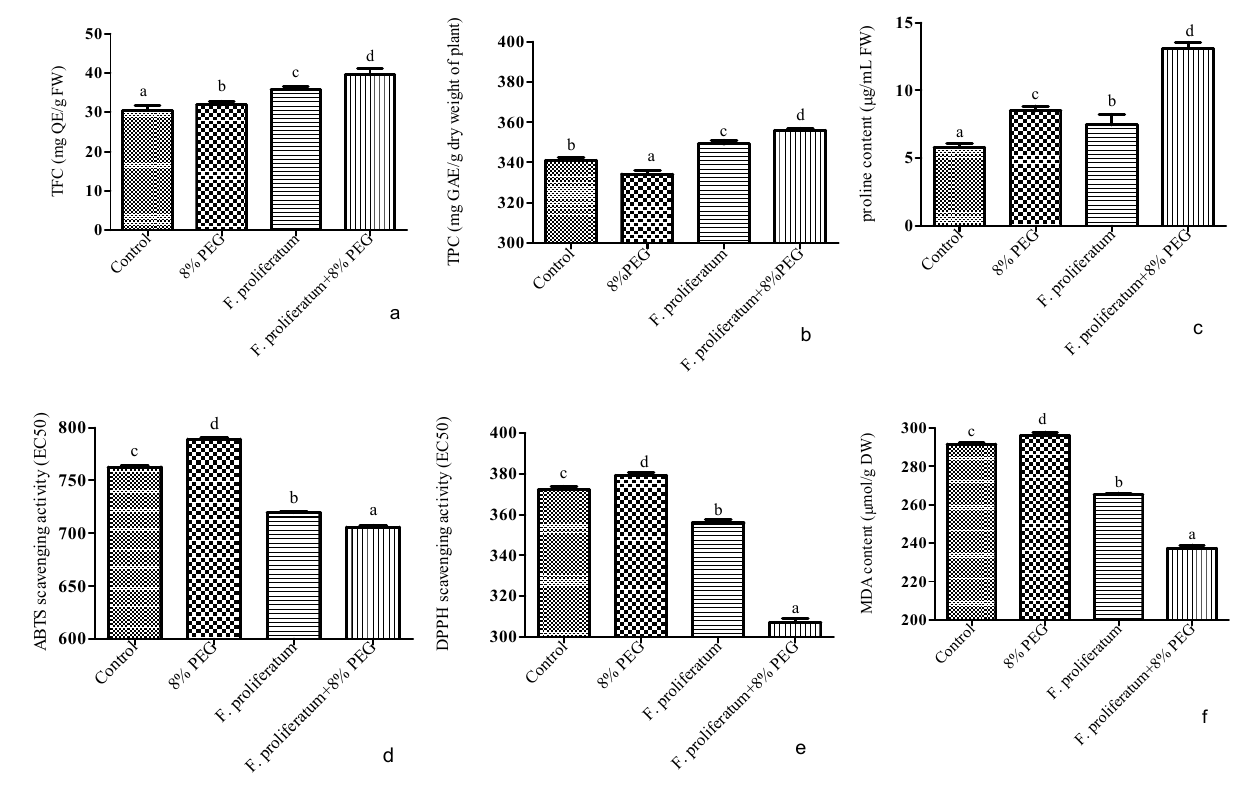
Figure 4. Effects of F. proliferatum on ( a ) TFC, ( b ) TPC, ( c ) proline, ( d ) ABTS, ( e ) DPPH, and ( f ) MDA content in sunflower seedlings grown under normal and drought conditions for 21 days. Bars represent mean of triplicates with SE ± . The alphabets represent significance at the level of p < 0.05.